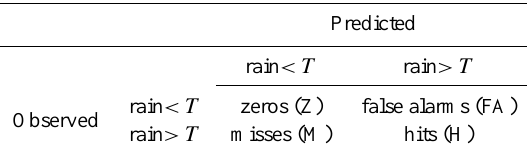
Table 6. Several Verification indexes for different thresholds for the second hour blending forecast (BLE), Model correction (MCO) and advection of reflectivity field (ADV) plotted in Fig. 6. Best results are marked in bold.